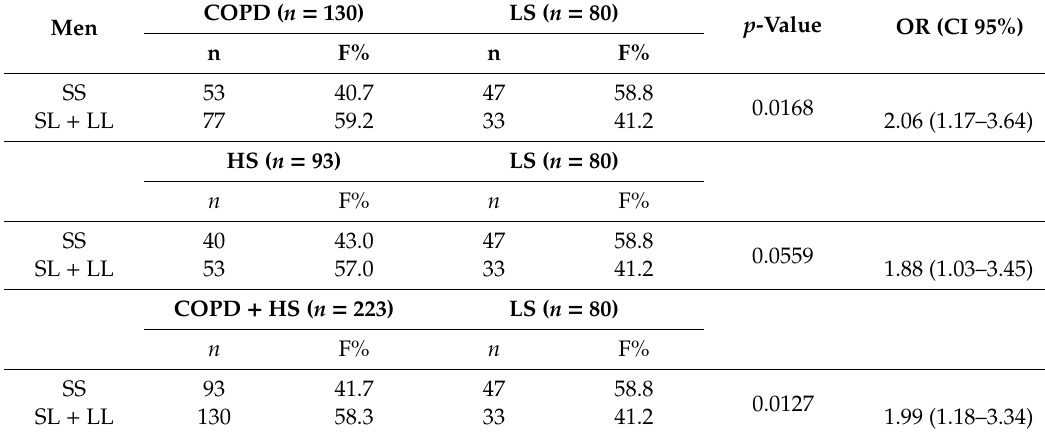
Table 3. The dominant model in men included in this